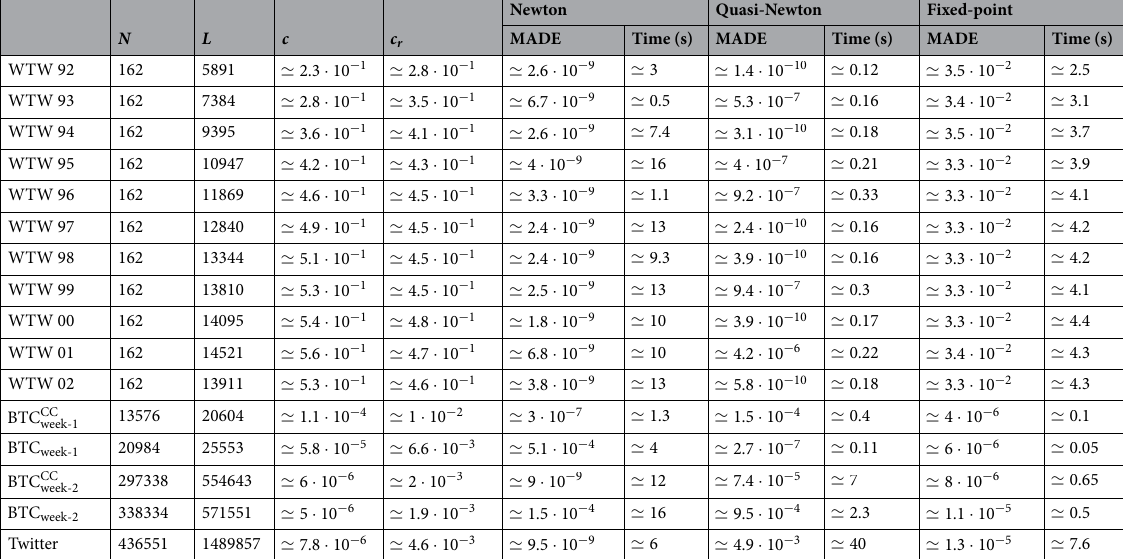
Table 2. Performance of Newton’s, quasi-Newton and the fixed-point algorithm to solve the reduced system of equations defining the DBCM, on a set of real-world BDNs (of which basic statistics as the total number of nodes, N , the total number of links, L , and the connectance, c concerns the World Trade Web, both Newton’s and the quasi-Newton methods stop because the condition 8 L ( 10 θ) is satisfied; the fixed-point recipe, instead, always reaches the limit of 10,000 steps. The 2 − � ||∇ || ≤ fastest and most accurate method is systematically the quasi-Newton one. The picture changes when very large networks, as Bitcoin and Twitter, are considered: in these cases, the fastest and most accurate method is the fixed-point one. Only the results corresponding to the best choice of initial conditions are